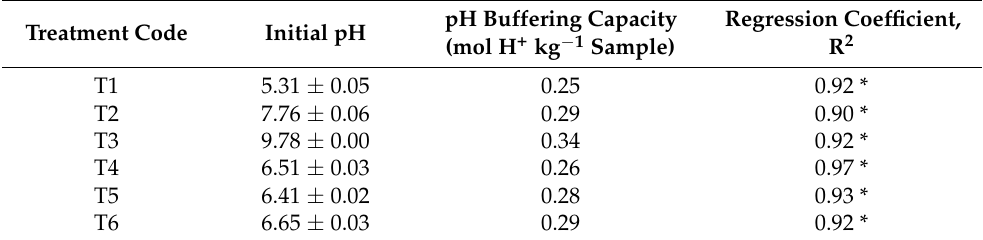
Table 4. Summary of pH buffering capacity as affected by soil alone, amendments alone, and soil with the amendments.